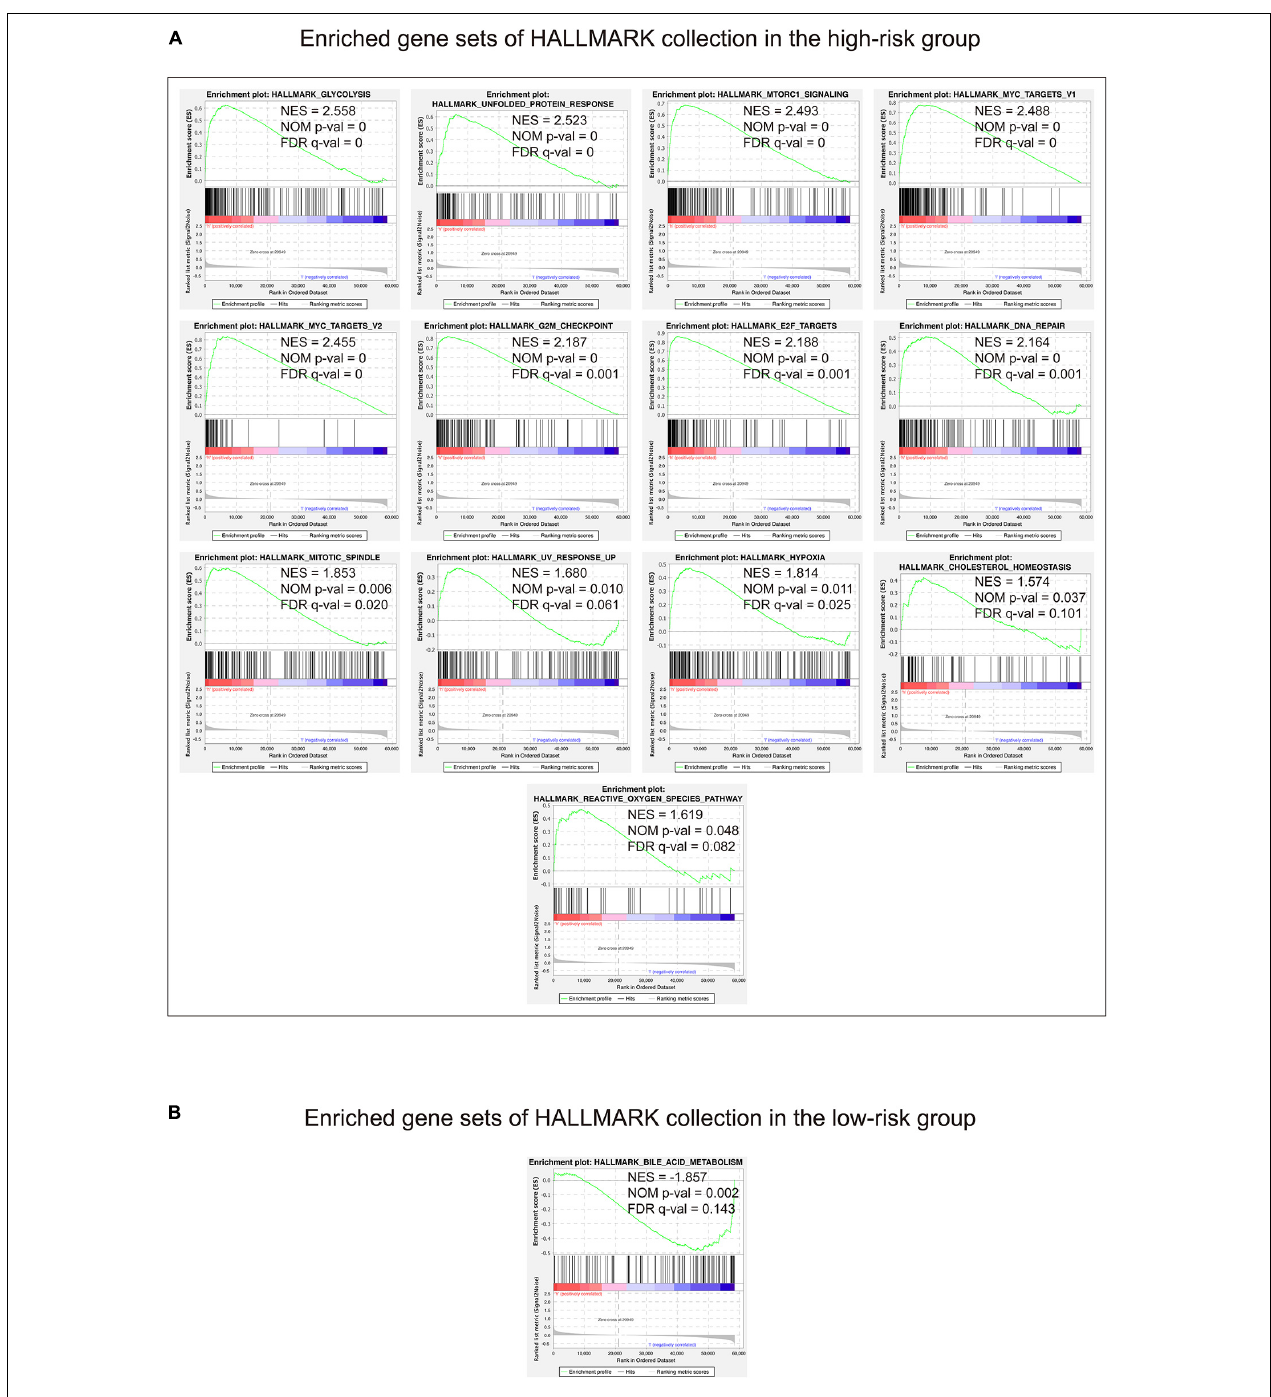
FIGURE 7 | Gene set enrichment analysis performed using HALLMARK collection. The figure shows the enriched gene sets in the high-risk (A) and low-risk (B) groups, respectively. Gene sets with | NES | > 1, NOM p -value <0.05, and FDR q -value < 0.25 were considered significantly enriched. H, high-risk group; l, low-risk